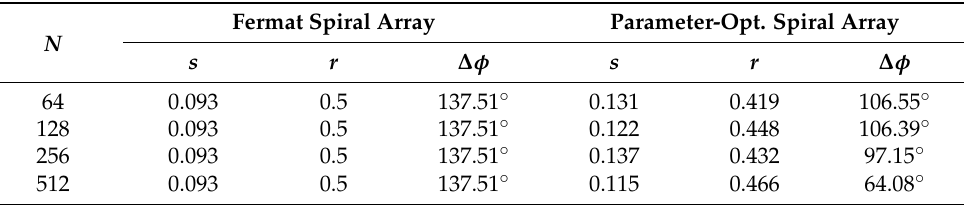
Table 1. The Geometric Parameters of Fermat Spiral Array and Parameter-Optimized Spiral Array with Different Sizes.